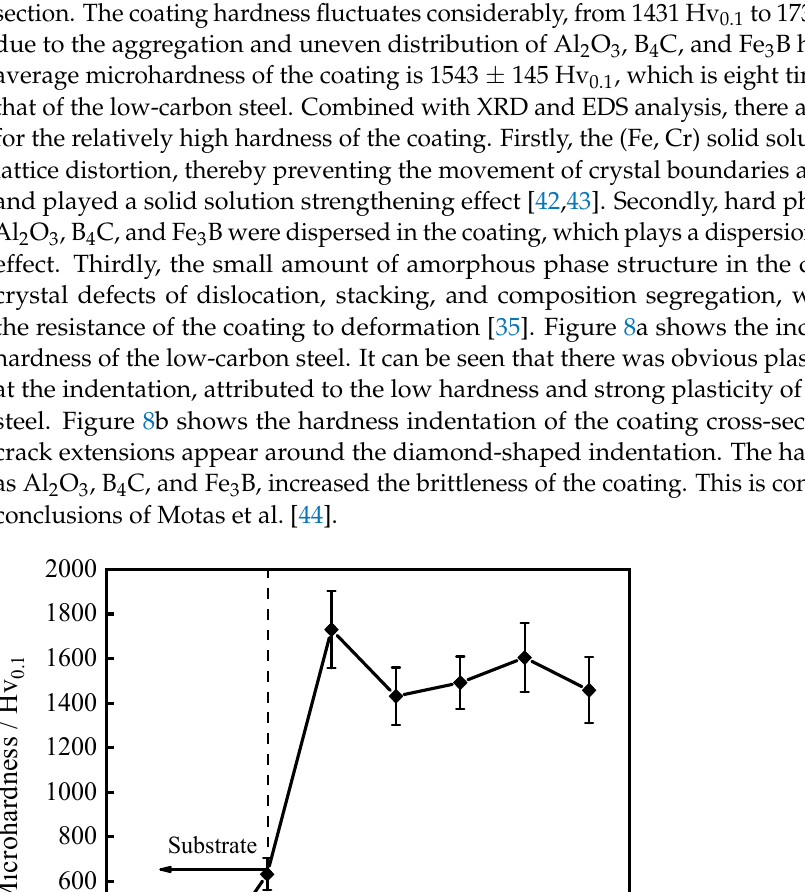
Figure 8. Cross-section hardness indentation ( a ) low-carbon steel; ( b ) Fe-based-Al 2 O 3 -B 4 C coating. 3.6. Wear Resistance Figure 9a,b shows the COF of the low-carbon steel and coating at different sliding speeds. The COF of low-carbon steel is greater than the COF of the coating at different speeds under the same load. Under the reciprocating action of the load, the hard rein- forcement phases play the role of a lubricant in the friction process, reducing the COF. The high hardness of the coating increased the resistance to plastic deformation and en- hanced the resistance to cutting and ploughing, resulting in a lower COF of the coating [45]. However, the COF of the coating was unstable and fluctuated more than that of the substrate. The irregular coating structure with dispersed hard phases and spalling pits caused an uneven wear surface. Under the action of reciprocating normal and tangential forces, the hard phases in the coating fell off. Extrusion deformation and shear failure occurred within the spalling pits, making the contact of the counterpart fluctuate greatly. Sliding speed is an important factor influencing the wear mechanism, impacting the material, causing mechanical deformation, and changing the friction interface’s tempera- ture [46]. Figure 9c shows the trend of the average COF of the substrate and coating at different sliding speeds. The COF of the substrate and coating decreases with the increase in sliding speed. Due to the low sliding speed, friction mainly manifests as local adhesion